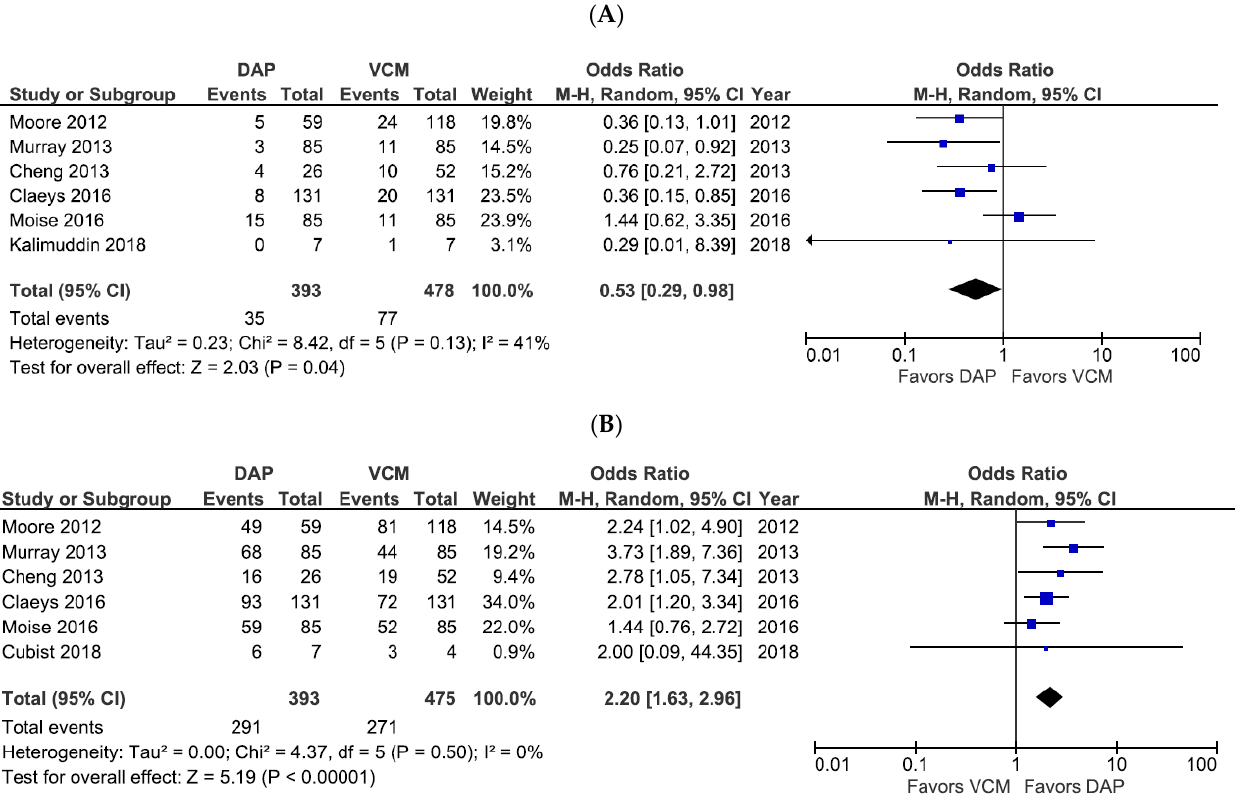
Figure 2. Forest plots of all-cause mortality and treatment success rates for patients treated with DAP versus VCM for bacteremia caused by MRSA with VCM MIC > 1 µg/mL. ( A , B ) Forest plots of the all-cause mortality rate ( A ) and treatment success rate ( B ) of patients treated with DAP versus VCM in the studies evaluated. The vertical line indicates no significant difference between the groups compared. Diamonds and horizontal lines represent the Mantel–Haenszel ORs and 95% CIs, respectively. Squares indicate point estimates, and the size of the square indicates the weight of each study included in the meta-analysis. CI, confidence interval; DAP, daptomycin; MIC, minimum inhibitory concentration; MRSA, methicillin-resistant Staphylococcus aureus ; OR, odds ratio; VCM, vancomycin.